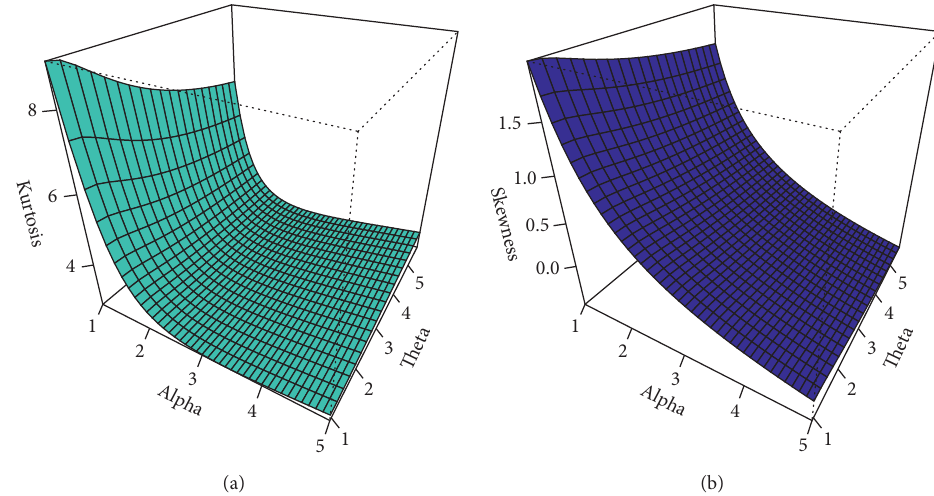
Figure 3: Plots for the skewness and kurtosis of the NGE-Weibull distribution.